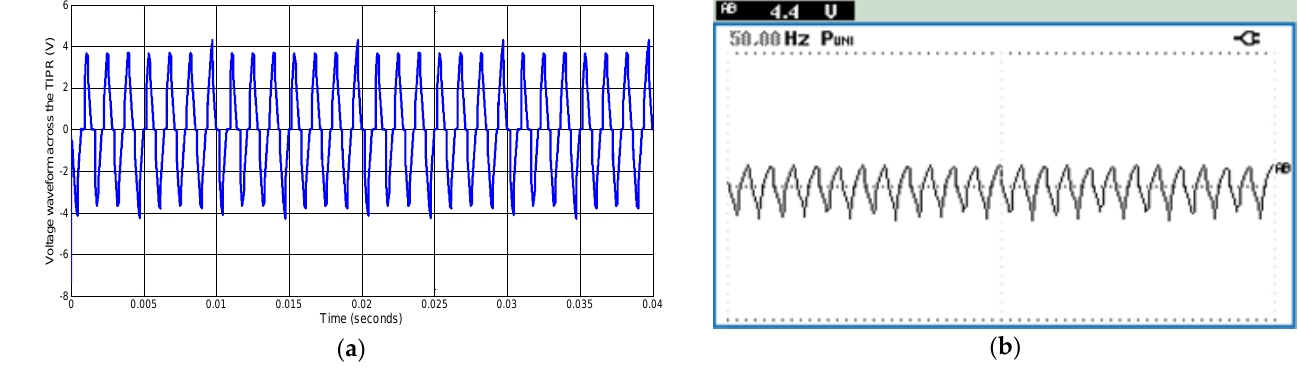
Figure 11. The voltage waveform across the TIPR: ( a ) simulation results, ( b ) experimental results.